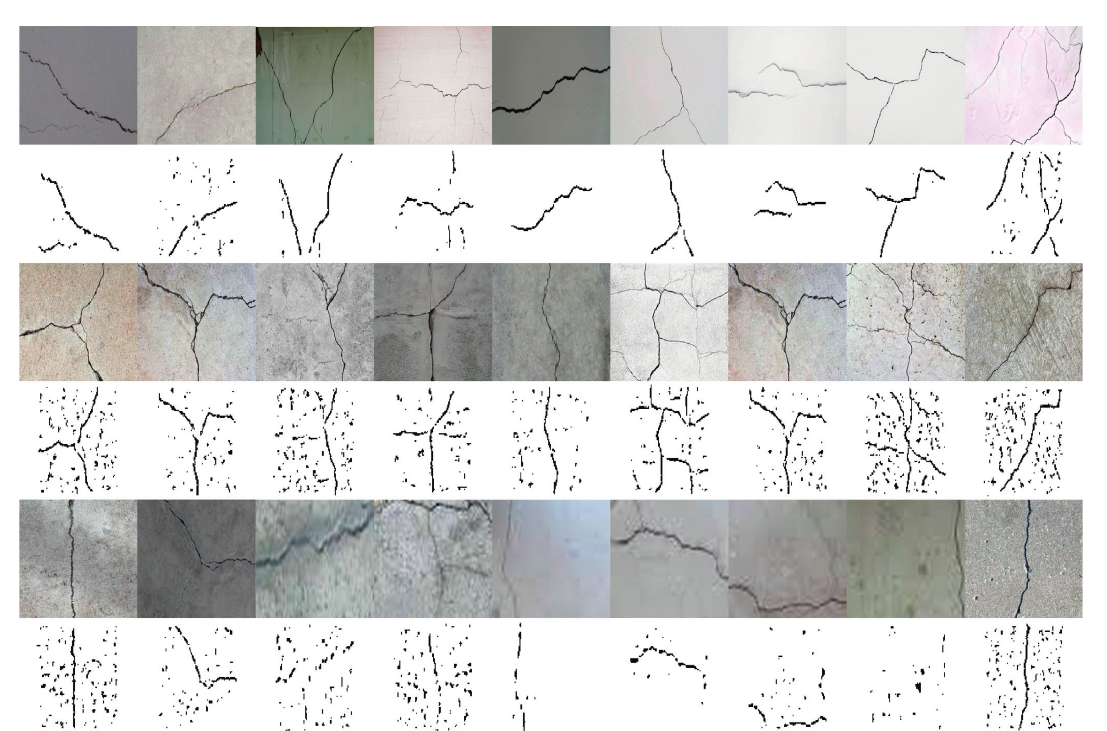
Figure 34: Percolation results using the enhanced percolation method with the linear